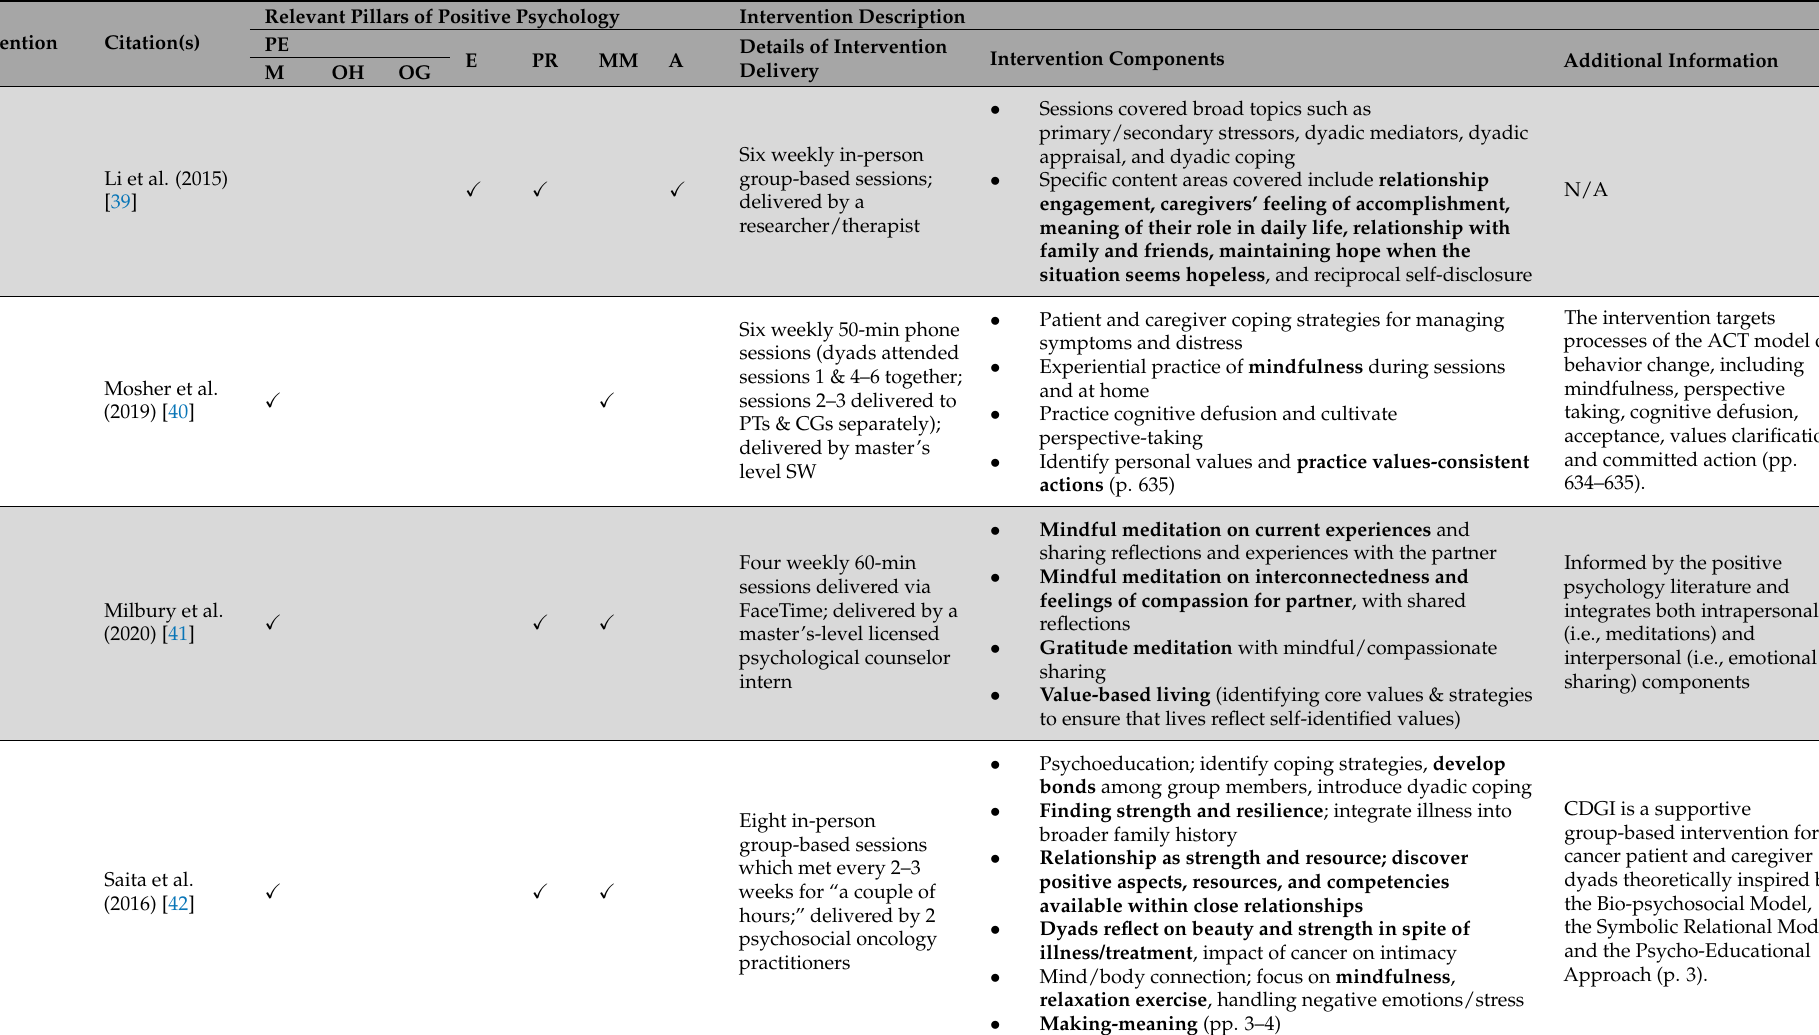
Table 2. Description of Interventions Included in this